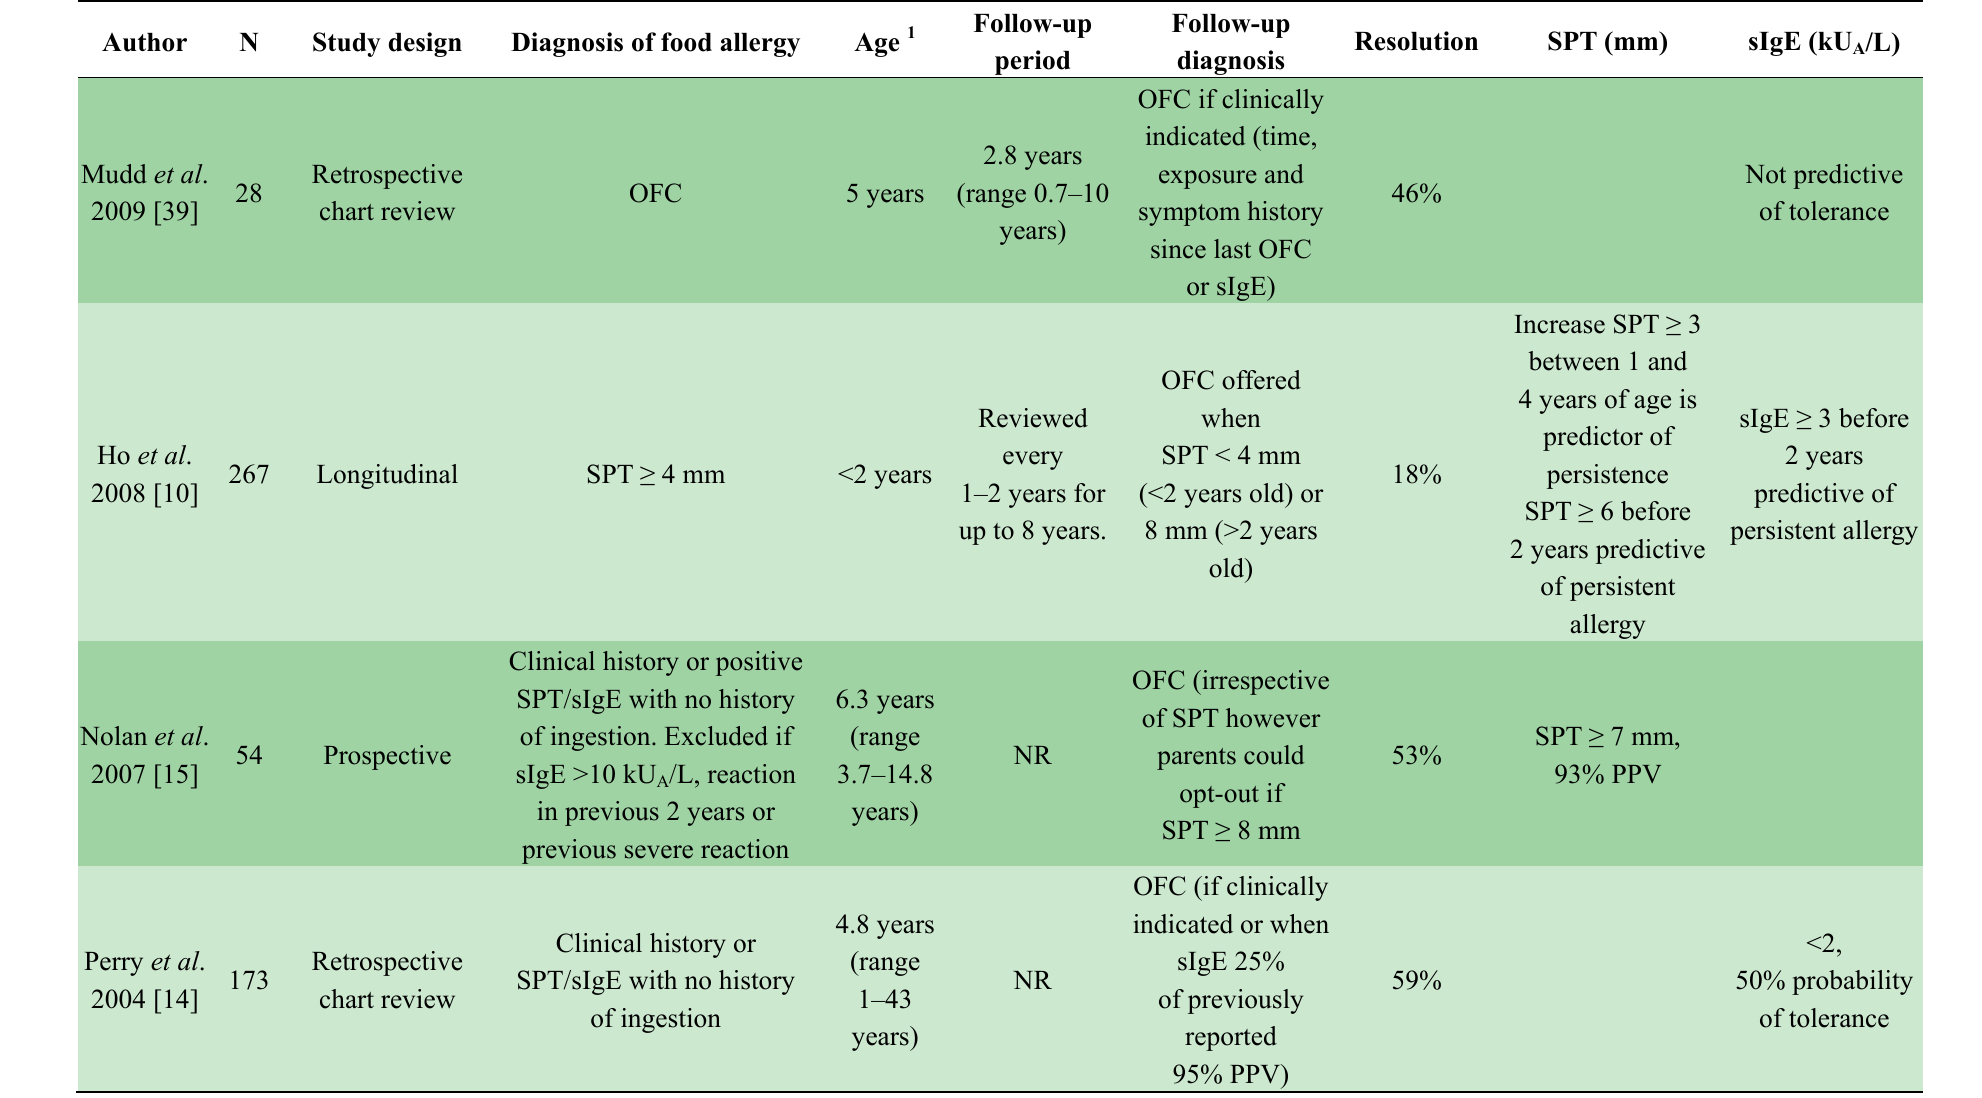
Table 1. Studies reporting on SPT and sIgE and the prognosis of PEANUT